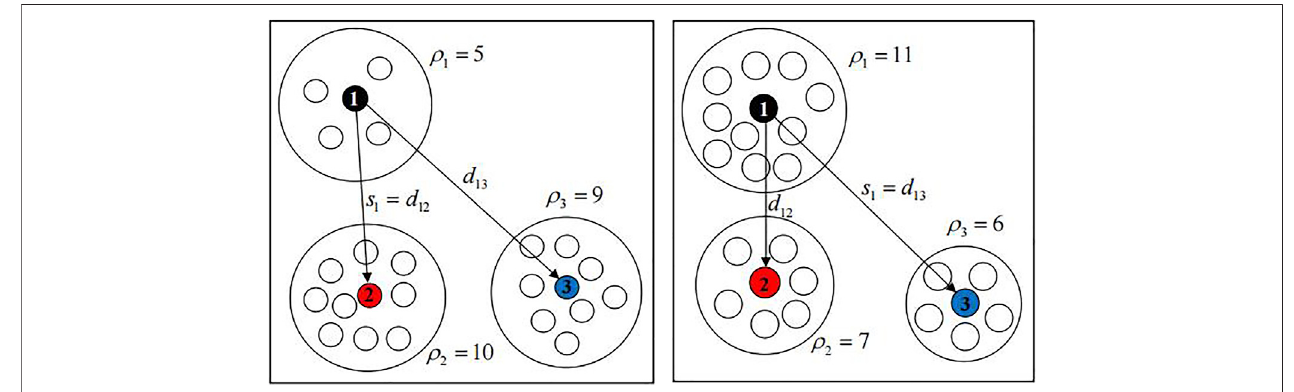
FIGURE 2 | Dissimilarity of candidate clusters s i